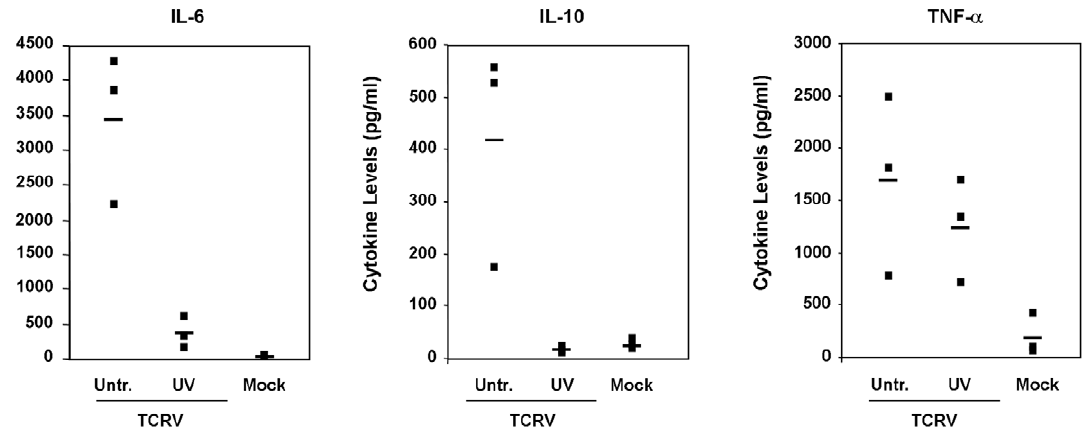
Figure 5. Cytokine production during exposure of primary human monocytes and macrophages to inactivated TCRV. Samples containing stock TCRV were inactivated by exposure to UV light for 60 min before being used to infect primary human monocytes at a dilution equivalent to an MOI of 0.1. Infection with untreated TCRV or mock infection of cells served as controls. Supernatants from the infected cells were analysed after 4 days using commercially available cytokine ELISA kits for IL-6 (left panel), IL-10 (center panel) and TNF- a (right panel) (R&D Systems) according to the manufacturer’s instructions. The cytokine concentration for each of three donors (black box), as well as the mean for each group (black bar) is indicated for each treatment group: Untreated TCRV (Untr.), UV-inactivated TCRV (UV) or Mock (M).